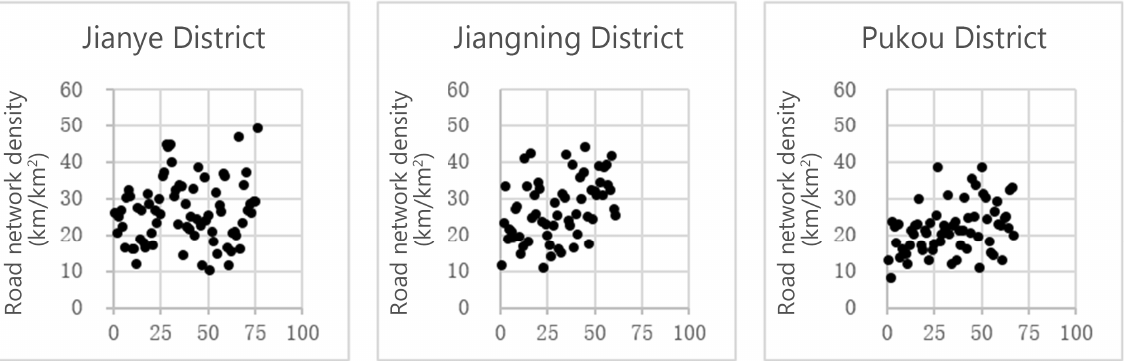
Figure 5. Road network density of 204 residential areas in Jiangning, Jianye, and Pukou District.